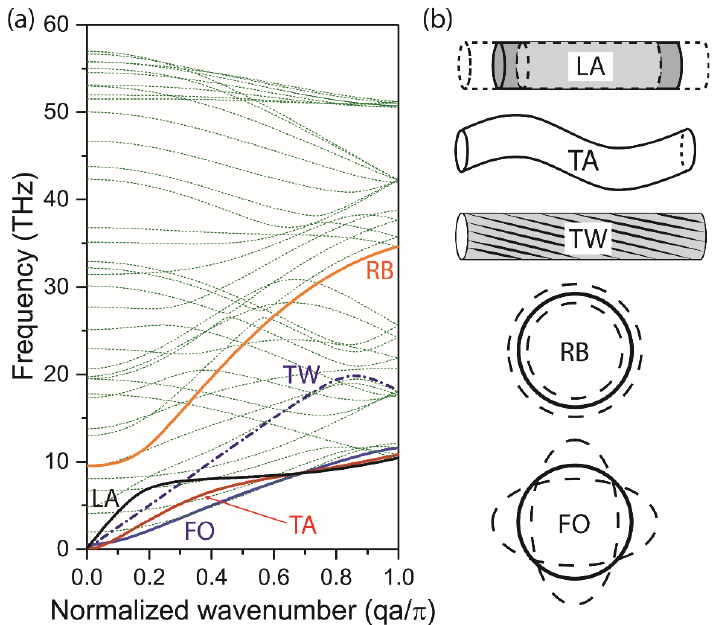
Figure 3. ( a ) Phonon dispersion relations in 1000 unit cells of (6,6) SWCNT. Five important phonon modes, i.e., LA, TA, TW, RB, FO modes are selected in this research. q denotes wave number and a denotes lattice constant. ( b ) Exaggerated illustration of LA, TA, TW, RB, FO vibrational modes.